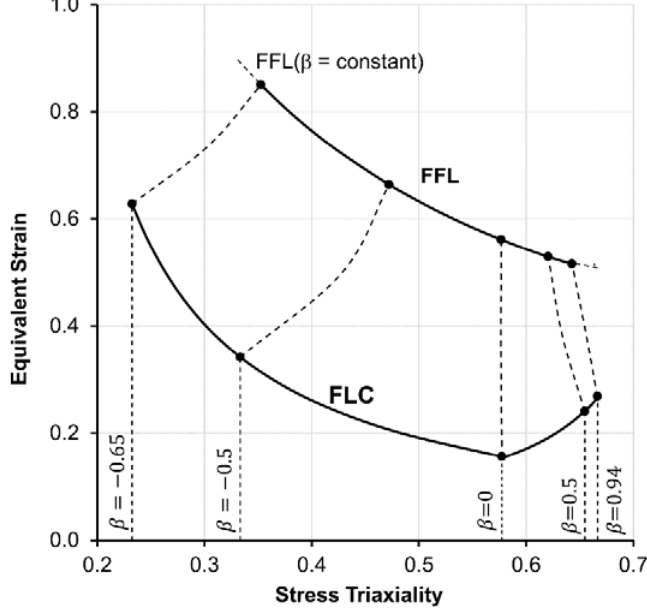
Figure 3. Forming limit curve (FLC) and fracture forming limit (FFL) line of the aluminum AA6063-T6 tube in the effective strain vs. stress triaxiality space, obtained from analytical transformation assuming material isotropy, linear strain paths and plane stress loading conditions.